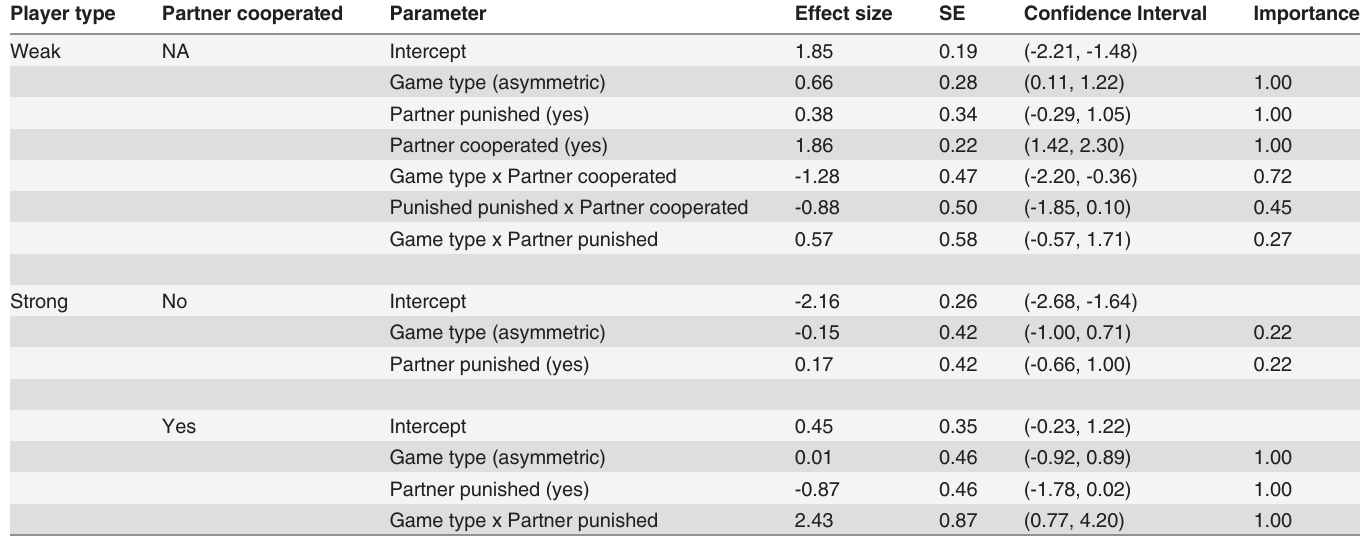
Table 6. Effect sizes, unconditional standard errors, con fi dence intervals and relative importance for parameters included in the top models investigating players' responses to being punished for defecting in the previous round (player continued to defect = 0, player switched to cooperating =